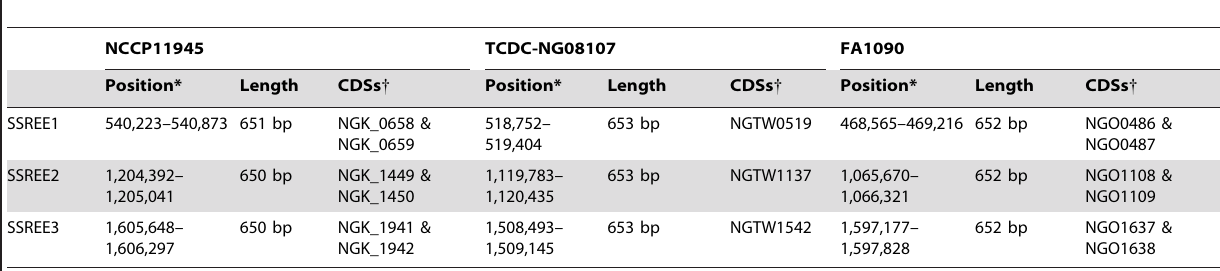
Table 2. Locations of the Spencer-Smith Repeat Enclosed Elements in N. gonorrhoeae .